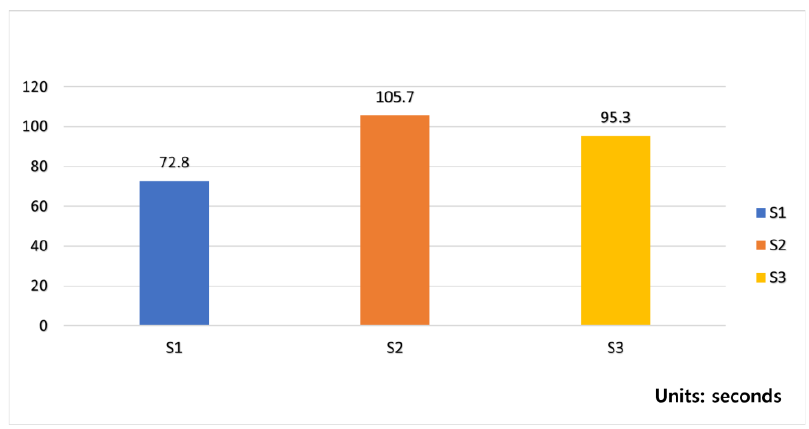
Figure 16. Average escape times under each scenario.